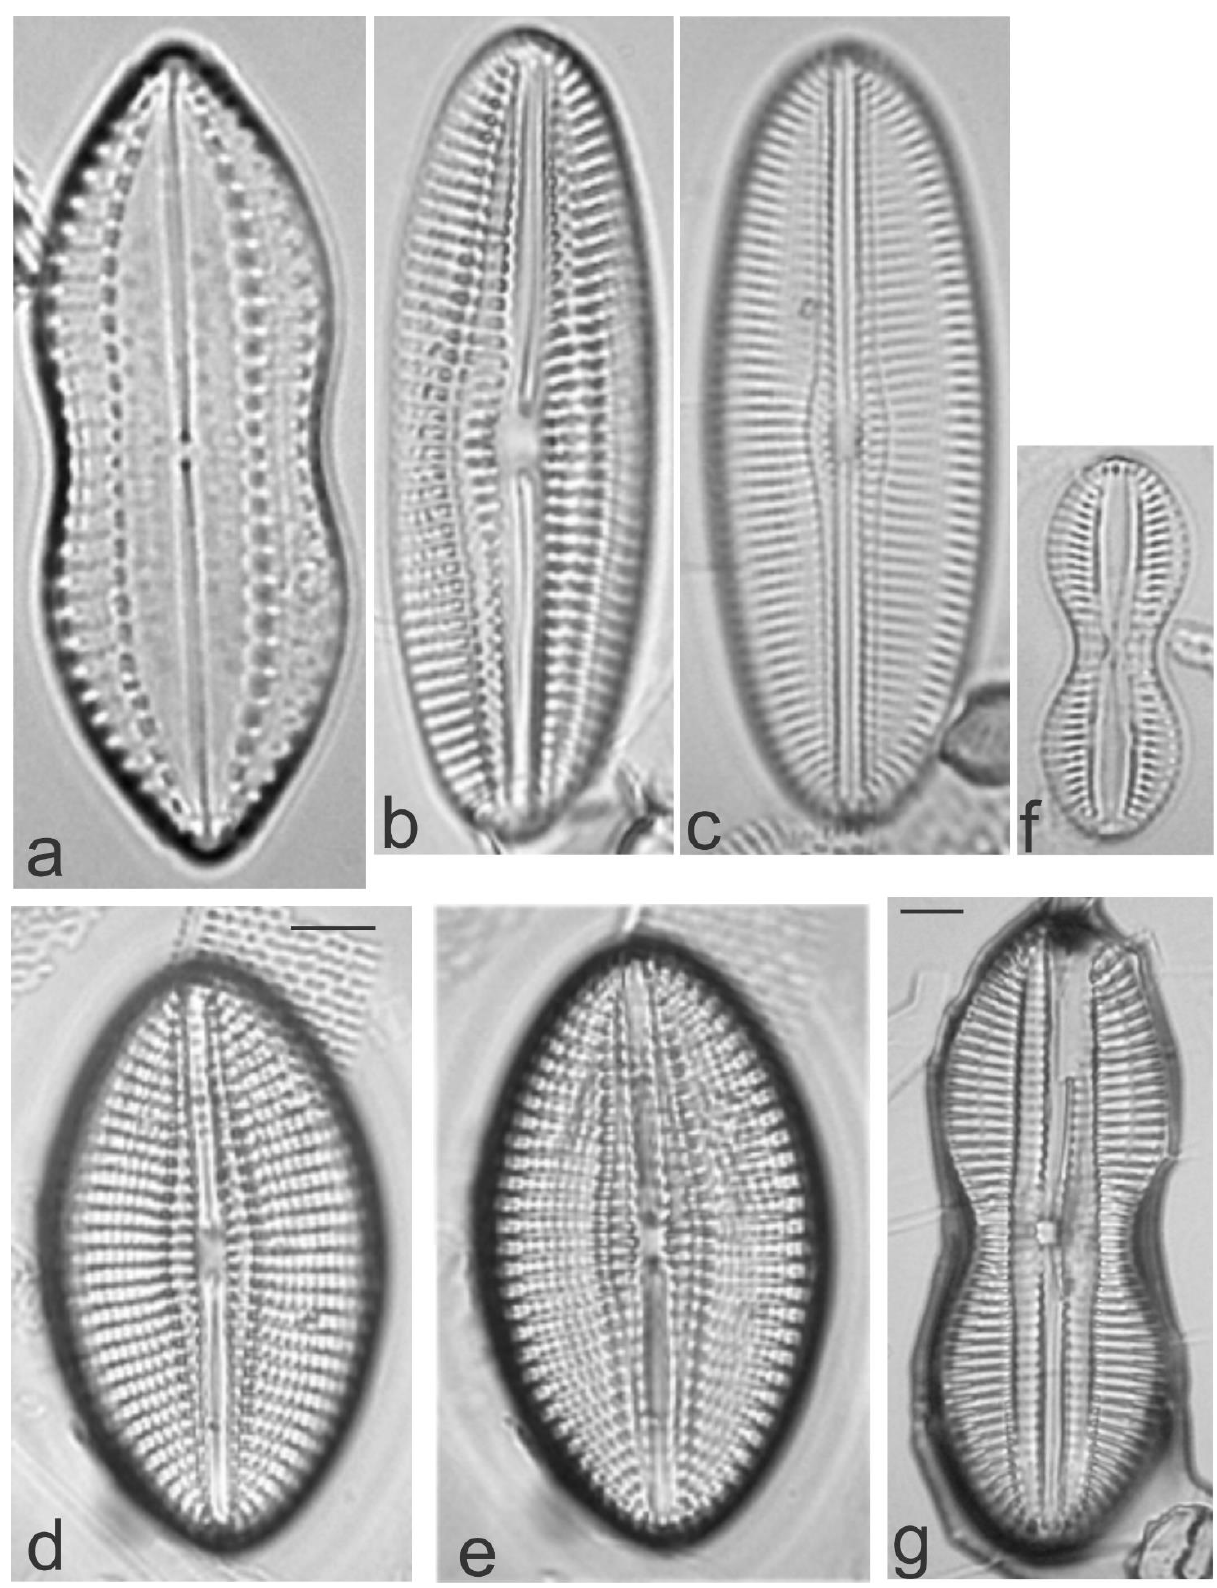
Figure 24. ( a ) Progonoia musca ; ( b ) Diploneis smithii var. recta ; ( c ) D. litoralis var. clathrata ; ( d , e ) D. smithii ; ( f ) Diploneis sp. 1; ( g ) D. gemmata var. pristiophora . Scale bar = 5 μm.